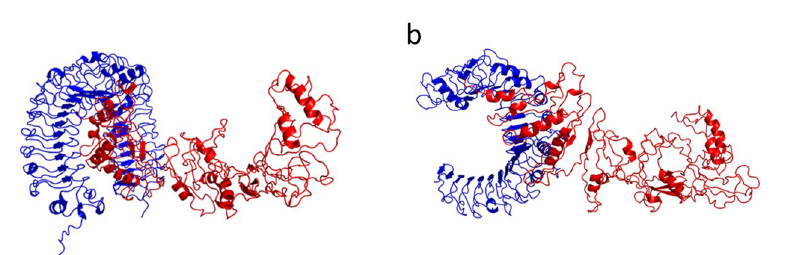
Figure 7. Molecular docking complexes predicted by Cluspro 2.0. ( a ) TLR4 (blue) and vaccine (red). ( b ) TLR2 (blue) and vaccine